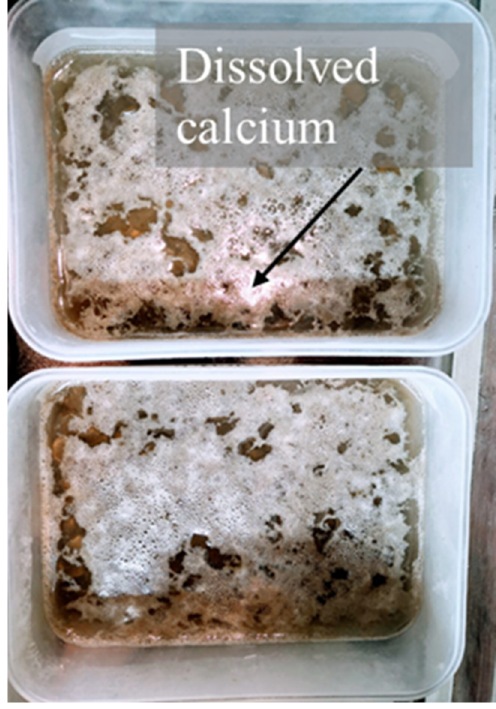
Figure 1. Calcium dissolved from RCA in acidic solution.